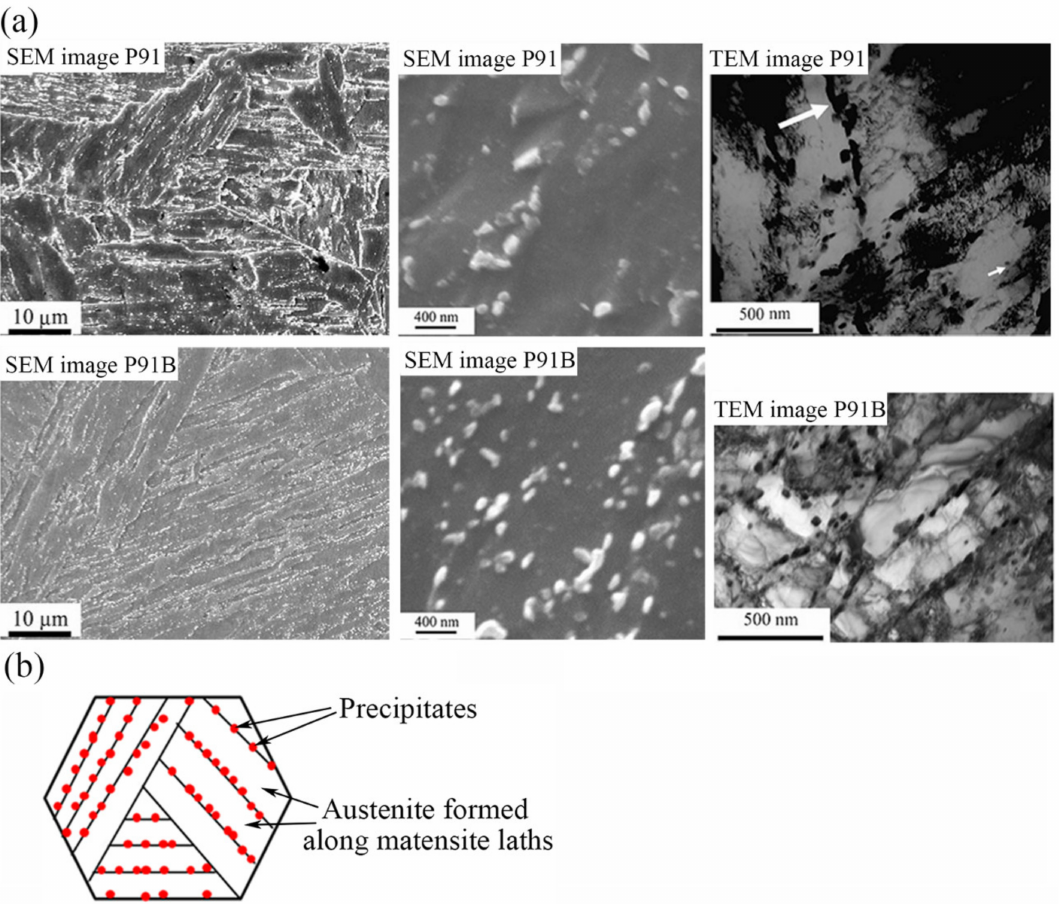
Figure 5. Microstructure of P91 and P91B, and the mechanism of restricting austenite growth by precipitate: ( a ) SEM and TEM images of base metals normalized at 1150 ◦ C and tempered at 760 ◦ C for 3 h [75] and ( b ) schematic diagram of restricted austenite